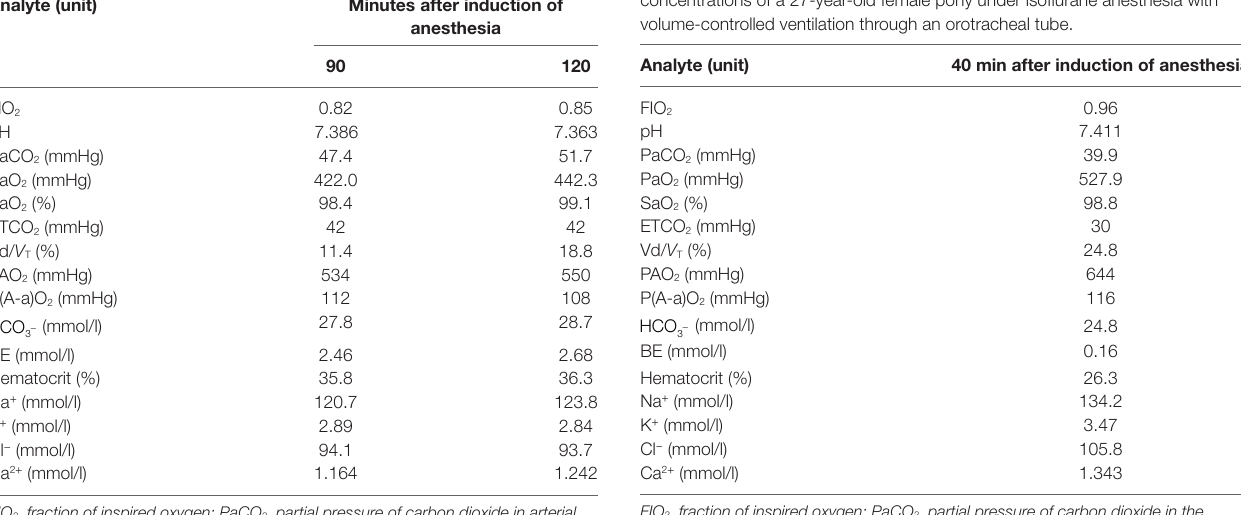
FIO 2 , fraction of inspired oxygen; PaCO 2 , partial pressure of carbon dioxide in arterial blood; PaO 2 , partial pressure of oxygen in arterial blood; SaO 2 , oxygen saturation; ETCO 2 , end-tidal carbon dioxide concentration; Vd/V T , alveolar dead space-to-tidal volume ratio; PAO 2 , partial pressure of alveolar oxygen; P(A-a)O 2 , alveolar-arterial oxygen pressure gradient; HCO 3 − , bicarbonate concentration; BE, base